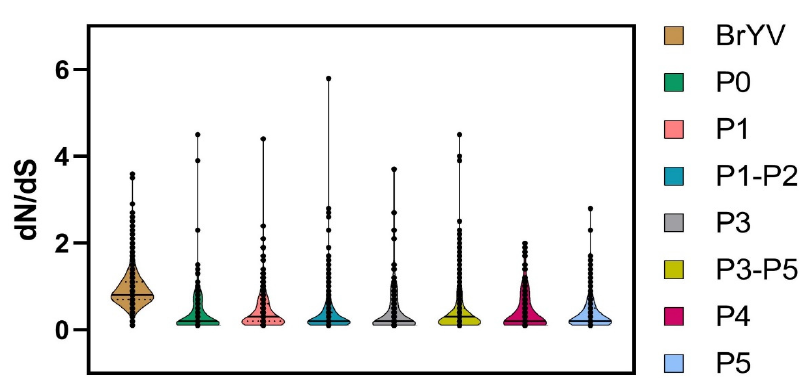
Figure 5. Estimation of selection pressure was performed by calculation of non-synonymous to synonymous substitution ratios (dN/dS). Violin plots correspond to dN/dS ratio for BrYV genome and its individual encoded genes. Solid horizontal lines represent median values, while dotted lines denote the lower and upper quartiles in each dataset. Table 4. Estimation of average dN/dS ratios and positive and negative selection for coding sequences of BrYV.